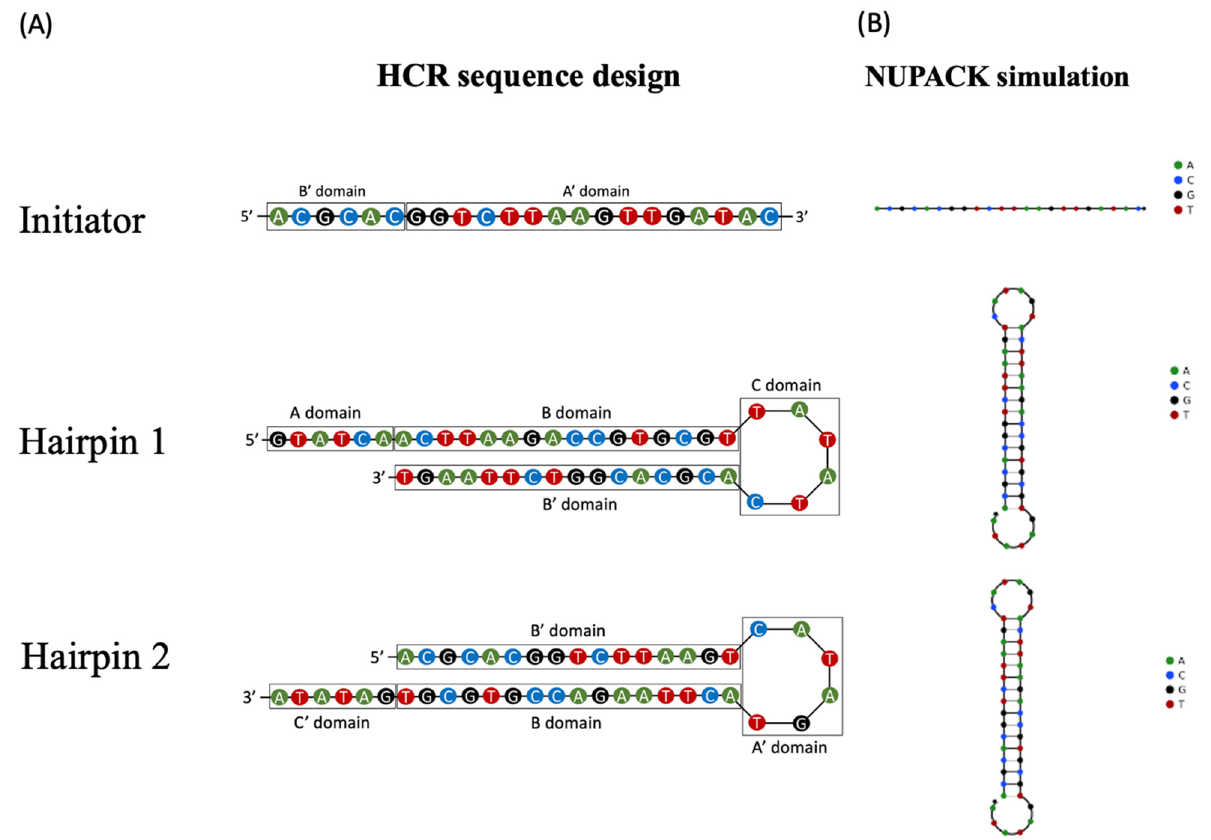
Figure 2. The design of three DNA aptamers that exhibit HCR signal amplification capabilities. ( A ) Schematic illustration of the HCR-pSPR detection aptamers. ( B ) Simulative schematics of the bare aptamer and the coupling DNA modified aptamer.